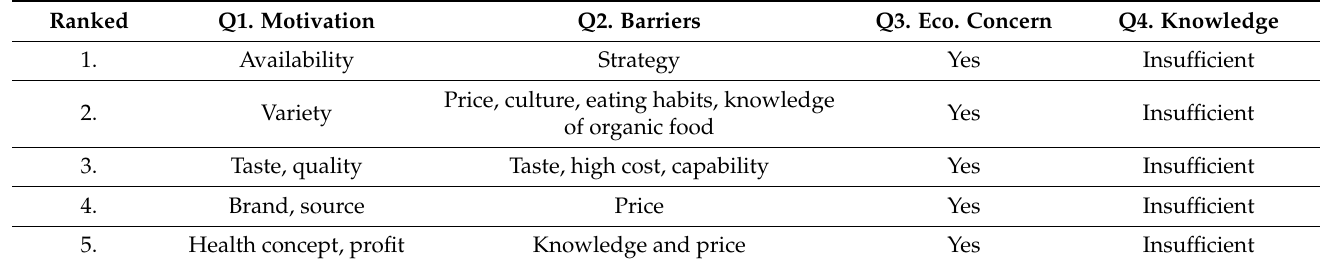
Table 4. Analysis of research questions for